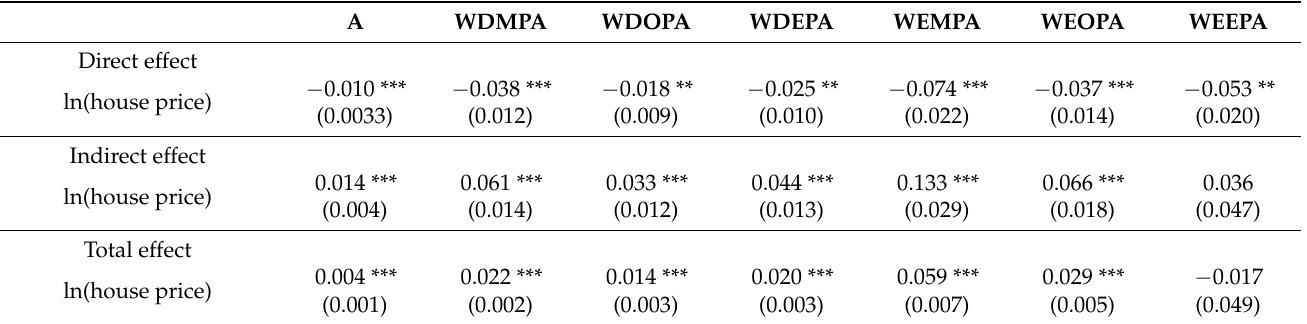
Table 4. Average effects of the spatial Durbin